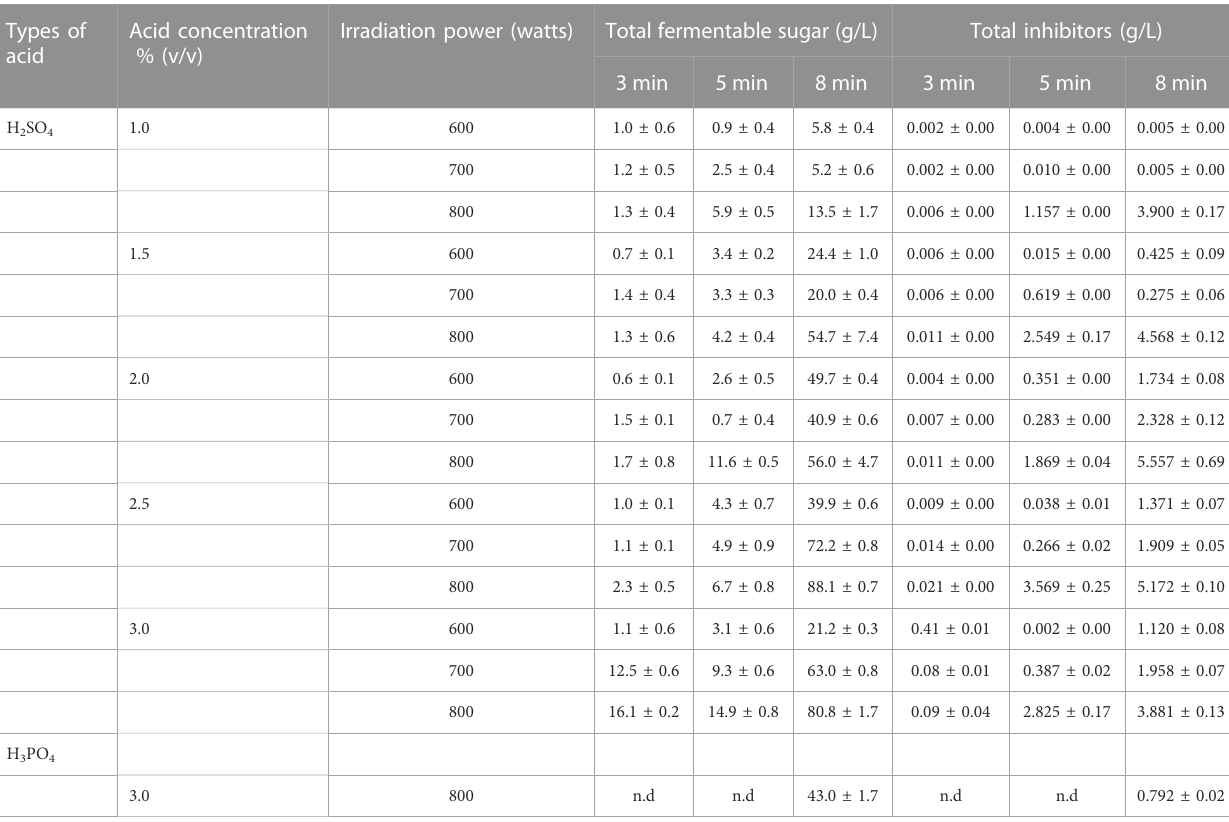
TABLE 3 Effect of H 2 SO 4 concentration, irradiation power and time on total fermentable sugar. Five grams of samples were hydrolyzed with 1, 1.5, 2, 2.5, 3% (v/v) H 2 SO 4 and 3% (v/v) H 3 PO 4 and wattage power was varied at 600 W, 700 W, and 800 W for 3, 5 and 8